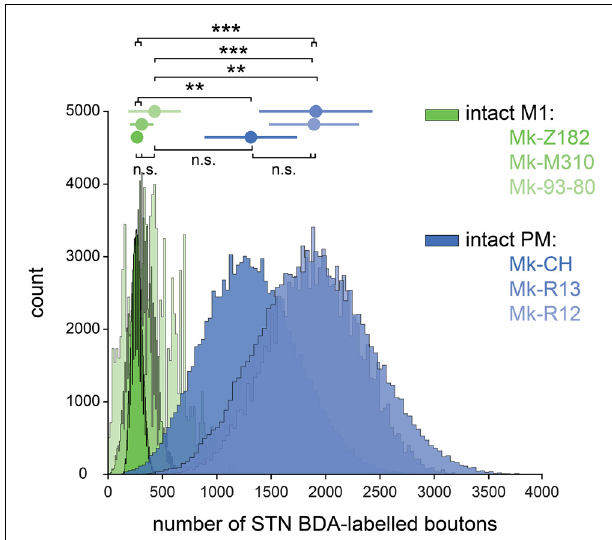
FIGURE 3 | Bootstrapped distributions (see “Materials and Methods” section) with the mean (dot) ± standard deviation (bars) of the corrected and normalized numbers of corticosubthalamic boutons observed in STN in the six intact monkeys injected with BDA in primary motor cortex (green) and in premotor cortex (blue). Statistical analysis (see “Materials and Methods” section) comparing each animal with all the five others (six groups in total). Statistically significant differences (Bonferroni correction for multiple-group comparisons) are indicated as follows: ** p < 0.0017, *** p < 1.6667e-04; “n.s.” refers to statistically non-significant ( p >